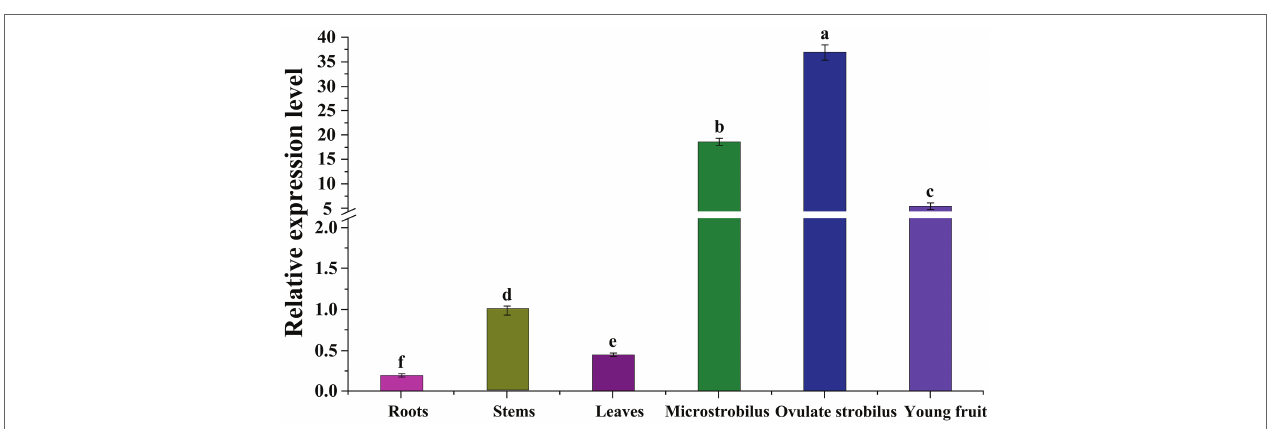
FIGURE 3 | Expression patterns of GbEMF2 in different organs of G. biloba with quantitative real-time PCR (qRT-PCR). Data are means ± SD for n = 3 biological replicates. Letters mean significant difference at p ≤ 0.05 by the Duncan’s multiple range